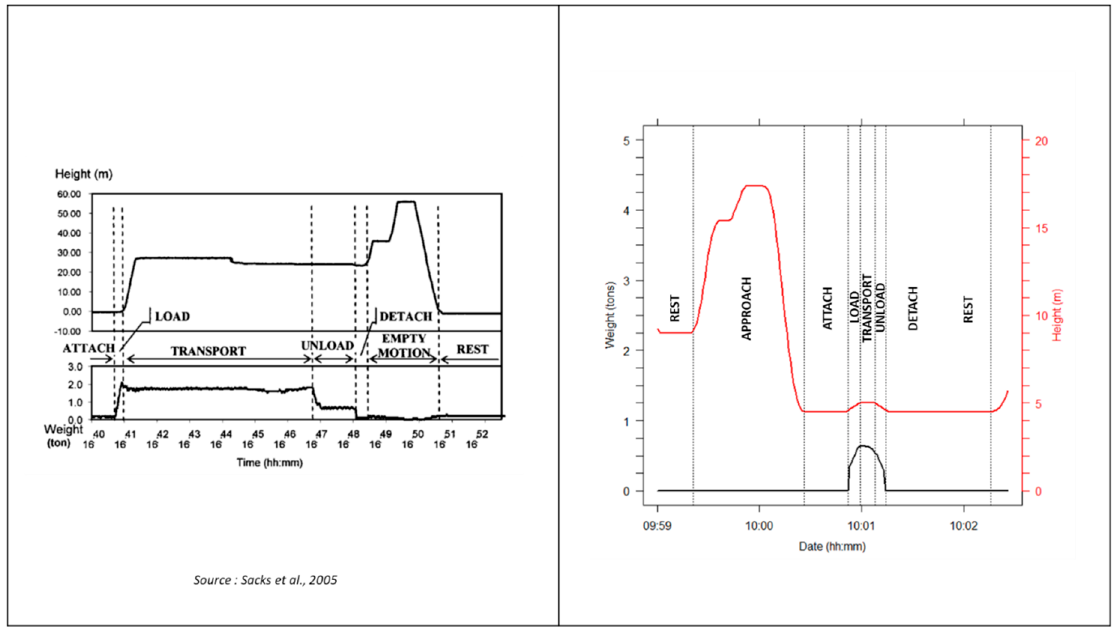
Figure 3. Comparative point of view between (Sacks et al., 2005) [34] and ours.